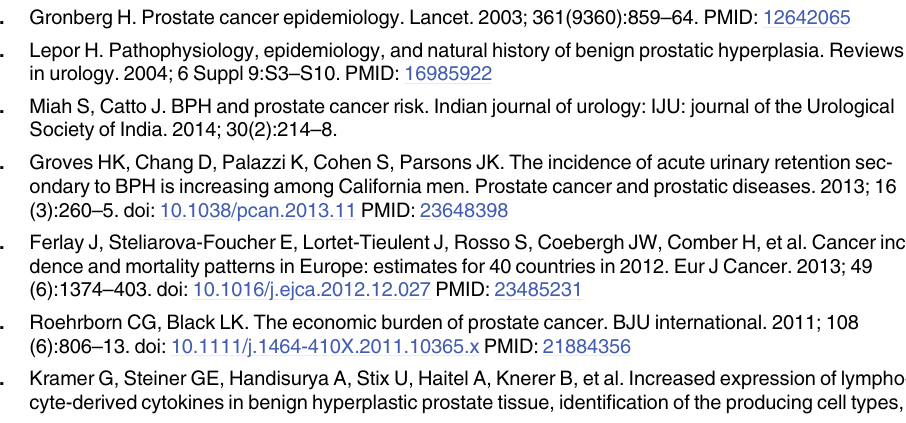
lesions, right side represents invasive prostate carcinoma. The basal cell marker, which is absent in malignant glands, confirmed correct discrimination of benign and tumor regions. B Statistical distribution of candidate marker proteins in benign prostate (BE, n = 75), benign prostatic hyperplasia (BPH, n = 27), primary carcinoma (CA, n = 58) and castration resistant prostate cancer (CRPC, n = 9) samples. H-Scores were used for quantification of immunoreac- tivity. SPAST and STX18 and SPOP protein expression was significantly increased in tumors compared to benign or BPH tissue, respectively. In CRPC expression of SPAST and SPOP disappeared whereas expression of STX18 remained constant compared to the primary